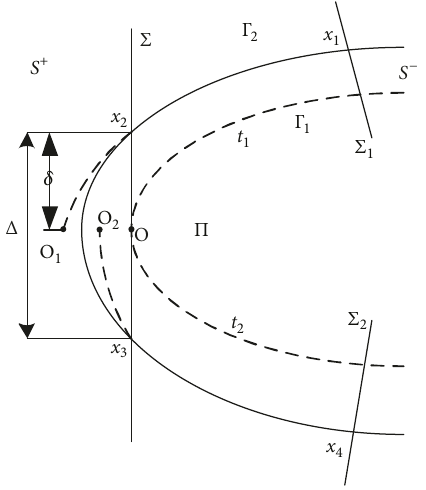
Figure 4: The critical discontinuous